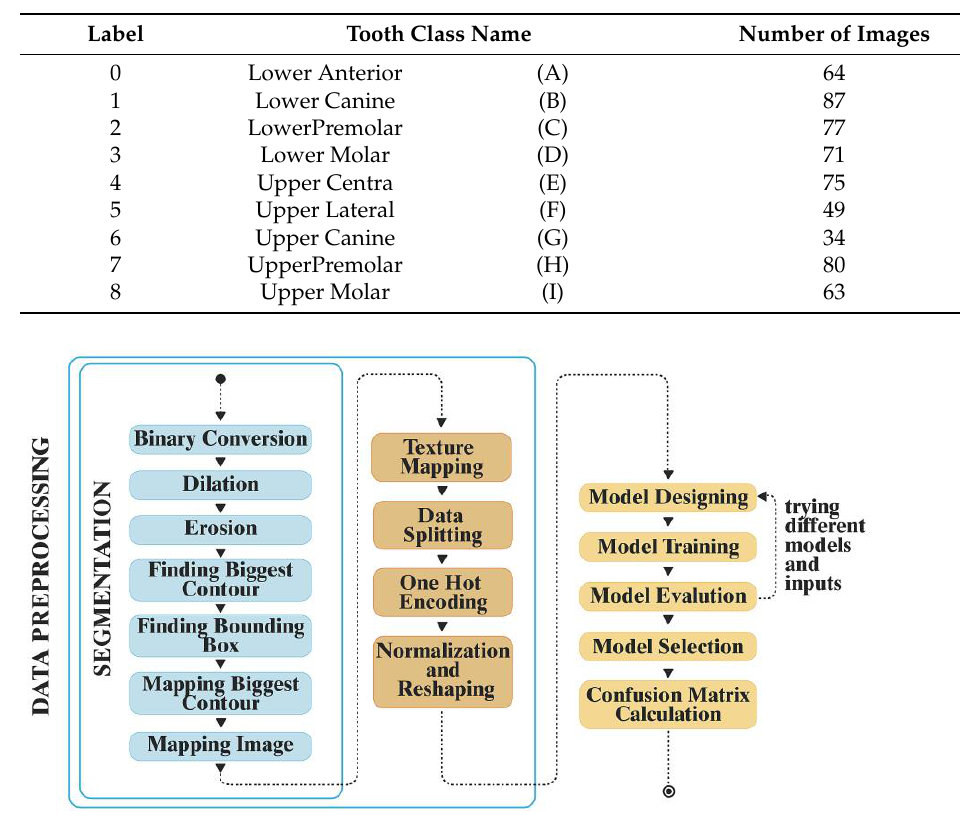
Table 1. Tooth classification and number of samples.